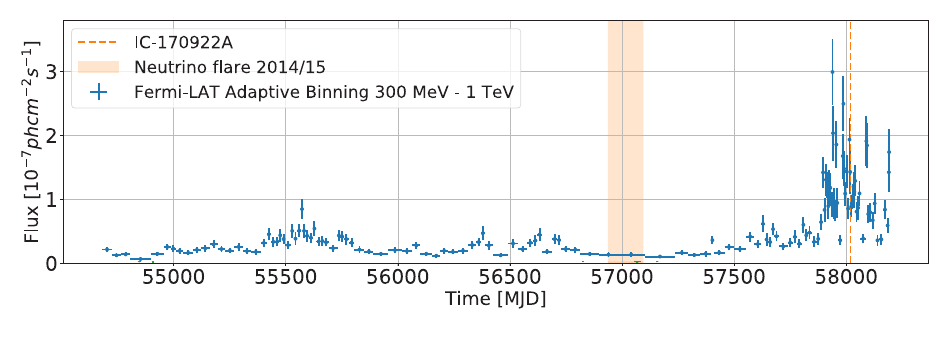
Figure 1. Adaptive binned gamma-ray light curve in the energy range from 300MeV to 1TeV. The vertical orange line shows the arrival time of IceCube-170922A and the orange band shows the duration of the lower-energy neutrino flare (see Finley et al. in these proceedings for more details). Figure adapted from